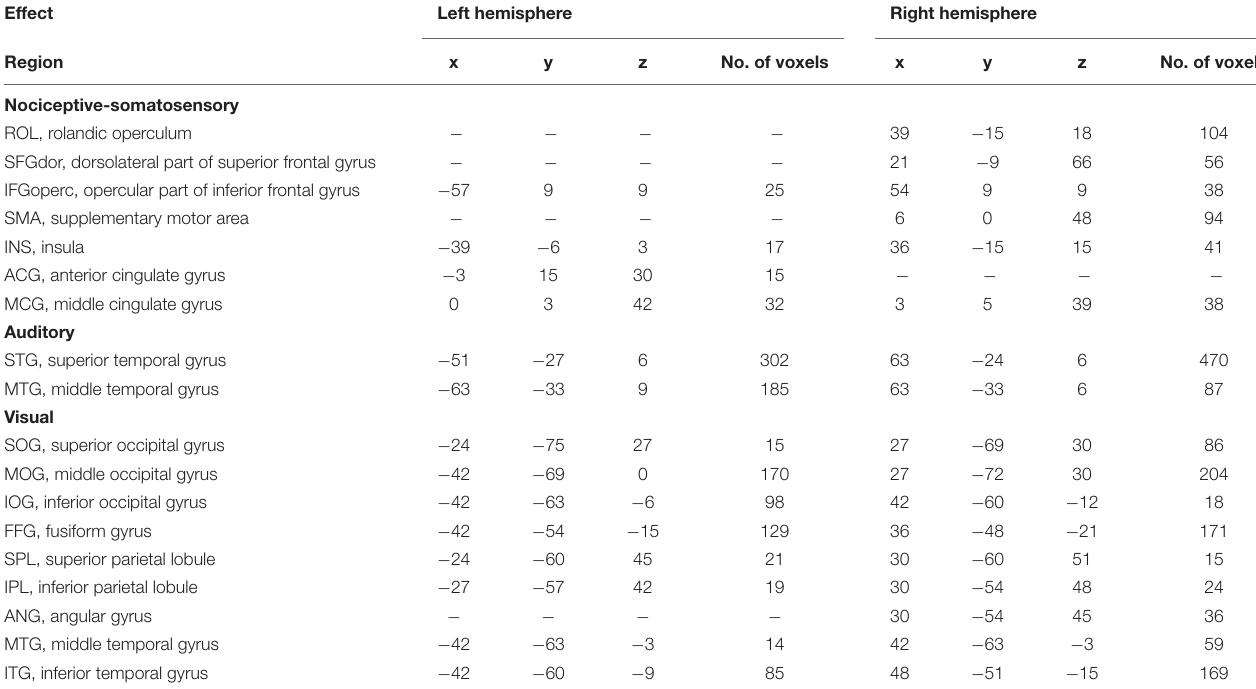
FIGURE 5 | Sensory modality-preferential regions defined by voxel-wise one-way repeated measures ANOVA. Significant results were identified at P < 0.0001 with FDR correction. ACG, anterior cingulate gyrus; ANG, angular gyrus; MCG, middle cingulate gyrus; FFG, fusiform gyrus; IFGoperc, opercular part of inferior frontal gyrus; INS, insula; IOG, inferior occipital gyrus; IPL, inferior parietal lobule; ITG, inferior temporal gyrus; MOG, middle occipital gyrus; MTG, middle temporal gyrus; ROL, rolandic operculum; SFGdor, dorsolateral part of superior frontal gyrus; SMA, supramarginal gyrus; SOG, superior occipital gyrus; SPL, superior parietal lobule; STG, superior temporal gyrus. TABLE 2 | List of modality-preferential brain regions as revealed by percentage signal change